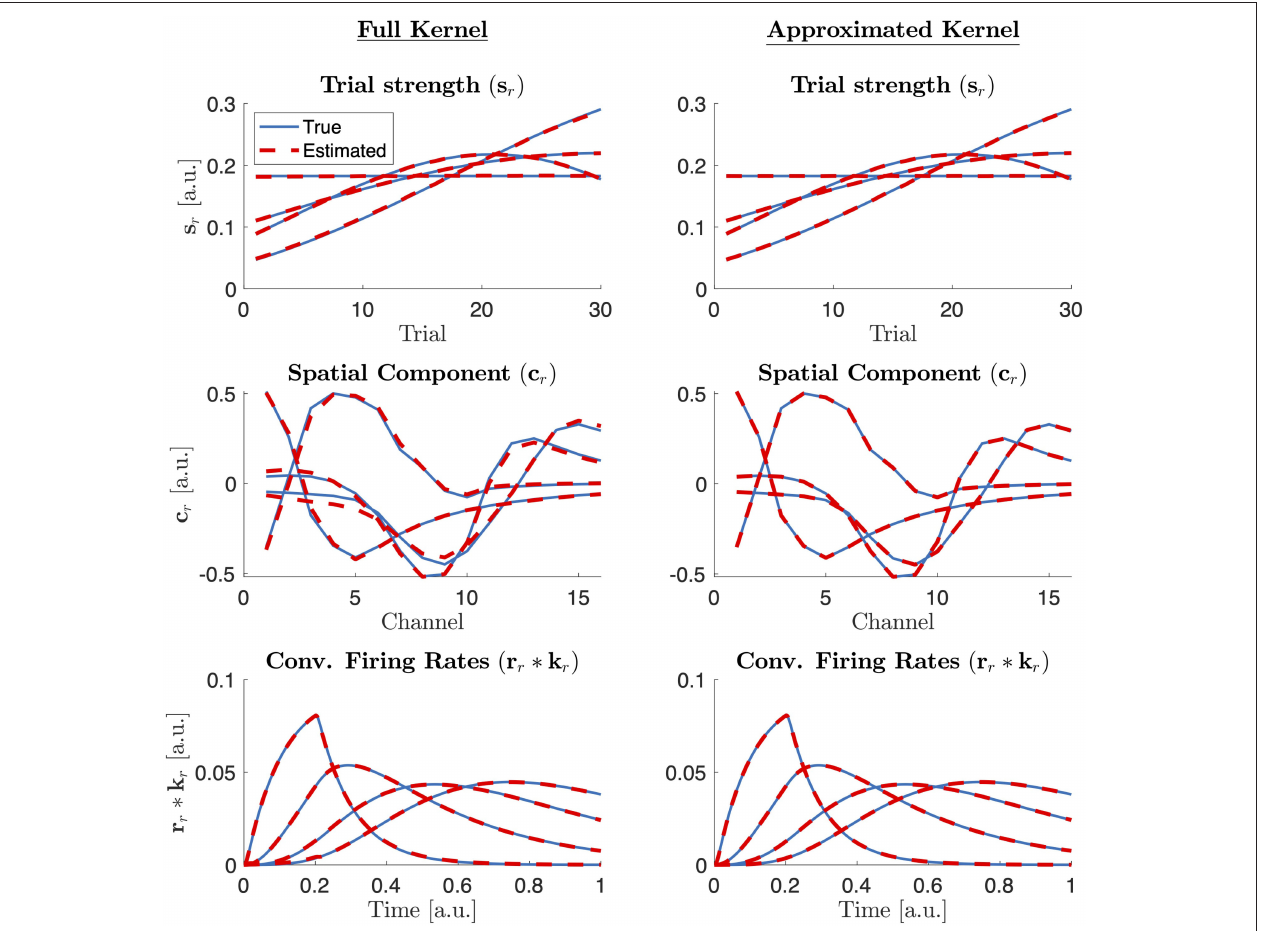
FIGURE 2 | True (simulated) components (blue solid line) vs. the factor vectors extracted by a 4-component CP model (red dashed) in trials , channels , and time modes from a tensor constructed via full kernels (left column) and rank one approximated kernels (right column). Note also that what is extracted by the CP model is ˆ t r which is then compared with r r * k r from the benchmarking